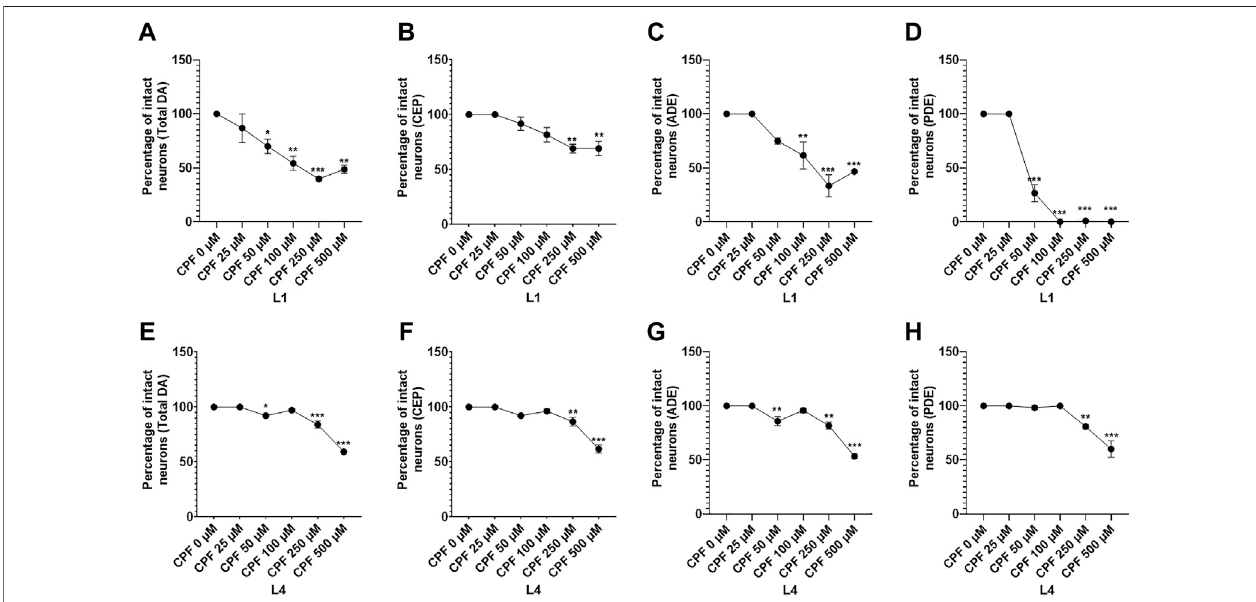
FIGURE 6 | Detailed evaluation of dopaminergic cell death with respect to neuron subtypes: (A – D) Graphical representation of the dopaminergic cell death with respecttoneuronalsubtypefortotal (A) ,CEP (B) ,ADE (C) ,andPDE (D) forwormstreatedattheL1stage. (E,F) Graphicalrepresentationofthedopaminergiccelldeath with respect to neuronal subtype for total (E) , CEP (F) , ADE (G) , and PDE (H) for worms treated at L4 stage. All experiments were conducted in three independent replicates Data were analyzed using one-way ANOVA followed by Dunnett ’ s post hoc test. * p < 0.05, ** p < 0.005, and *** p < 0.001 ( n = 3).